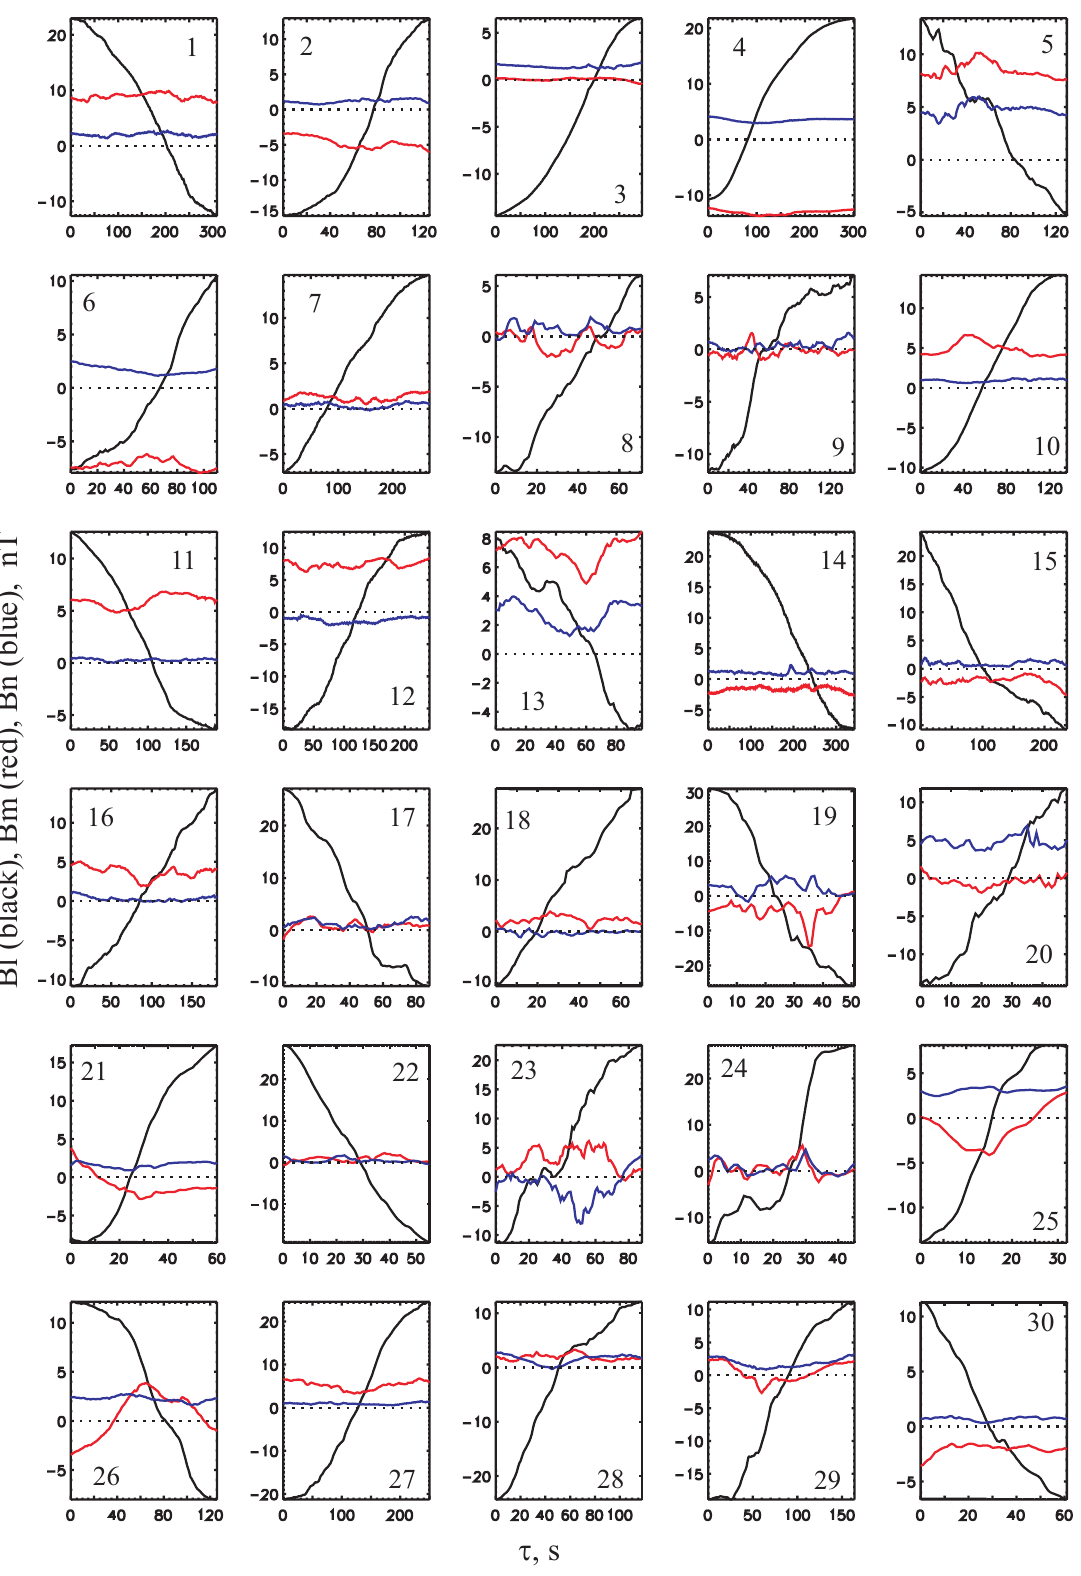
Fig. 1. Time series of the magnetic field at the Cluster barycenter in local normal coordinate system { l , m , n } (see text for details) for 30 selected cases. B l : black, B m : red and B n :